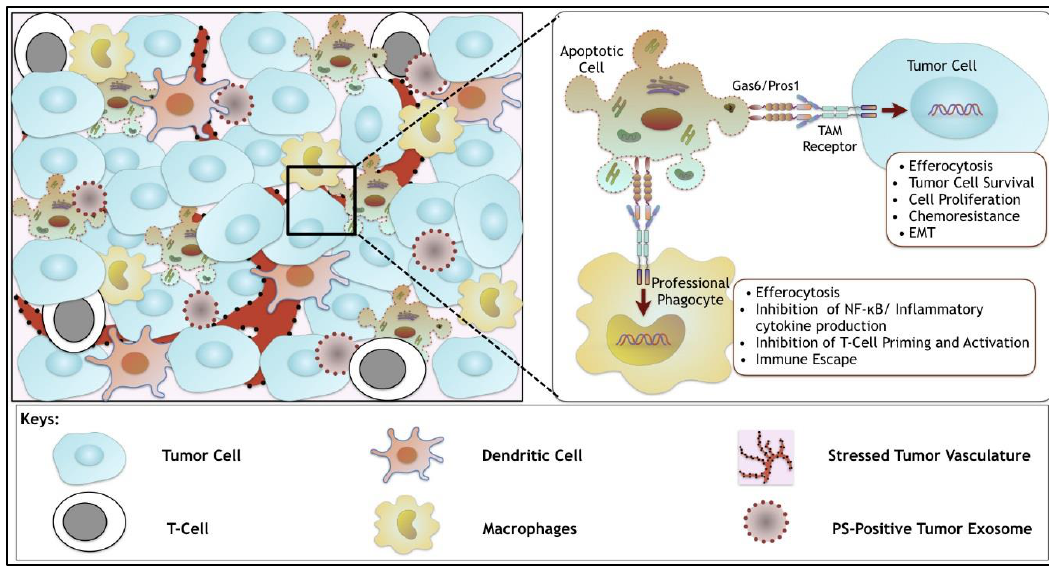
Figure 3. The role of TAM receptors in the tumor microenvironment. Various types of cells including tumor cells, macrophages, DCs, T-cells and apoptotic cells in addition to stressed tumor vasculature and phosphatidylserine (PS) positive tumor exosomes contribute to the tumor vasculature. In the tumor microenvironment, Gas6 binds to PS on the apoptotic cells and tumor exosomes and activates TAM receptors (TAMs) on tumor cells as well as on phagocytes such as macrophages, and DCs (professional phagocytes). Activation of TAMs on the tumor cells drive tumor growth and metastasis via downstream effector signaling leading to tumor cell survival, proliferation, chemoresistance and EMT phenotypes. On the other hand, activation of TAMs on the professional phagocytes leads to engulfment of